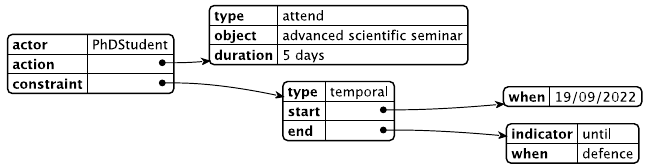
Figure 5: Partial instantiation of the rule called “advanced scientific seminar” with the actual start date and keeping the meta-information about the end field until it is not